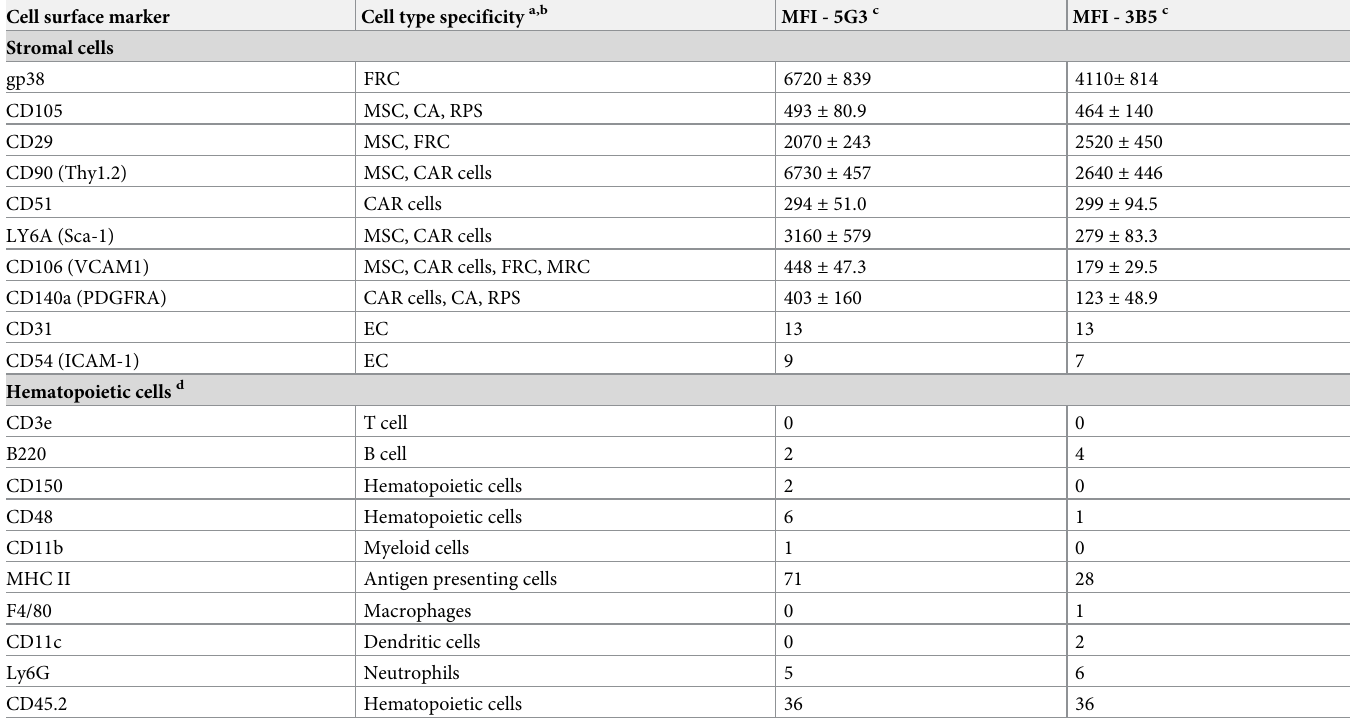
Table 1. Cell surface markers expressed by